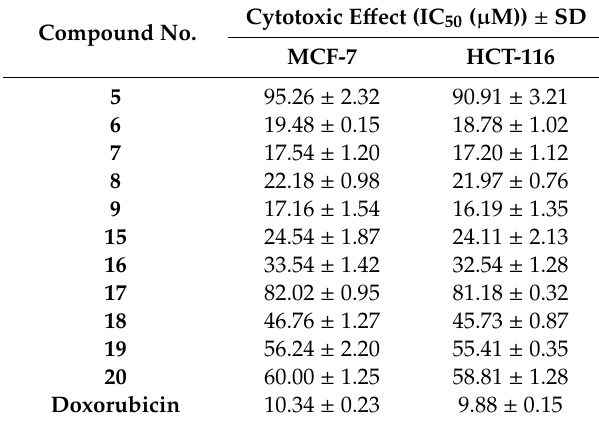
Table 1. Preliminary in vitro cytotoxicity values of some new synthesized compounds. Compound